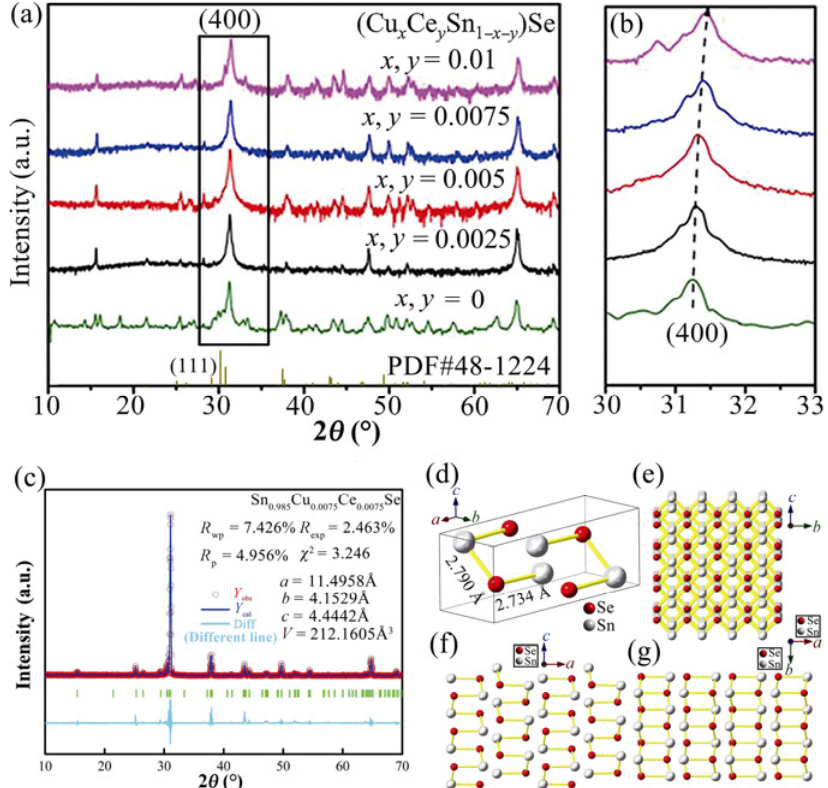
Fig. 2 (a) XRD patterns of Sn 1 − x − y Cu x Ce y Se with increase of Cu and Ce contents. (b) Magnified XRD patterns for (400) peaks. (c) Rietveld refinement result of Sn 0.985 Cu 0.0075 Ce 0.0075 Se sample. (d) Unit cell of co-doping Sn 0.98 Ce 0.01 Cu 0.01 Se and crystal structures along (e) a -axis, (f) b -axis, and (g) c